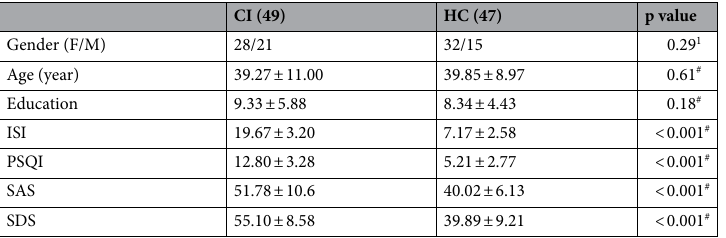
Table 1. Demographic and scale data of all study participants. Unless otherwise noted, data are presented as mean ± standard deviation. 1 The P value was obtained using the chi-square test. # The P value was obtained using Wilcoxon rank sum tests. CI chronic insomnia, HC healthy control, ISI insomnia severity index, PSQI Pittsburgh sleep quality index, SAS self-rating anxiety scale, SDS self-rating depression